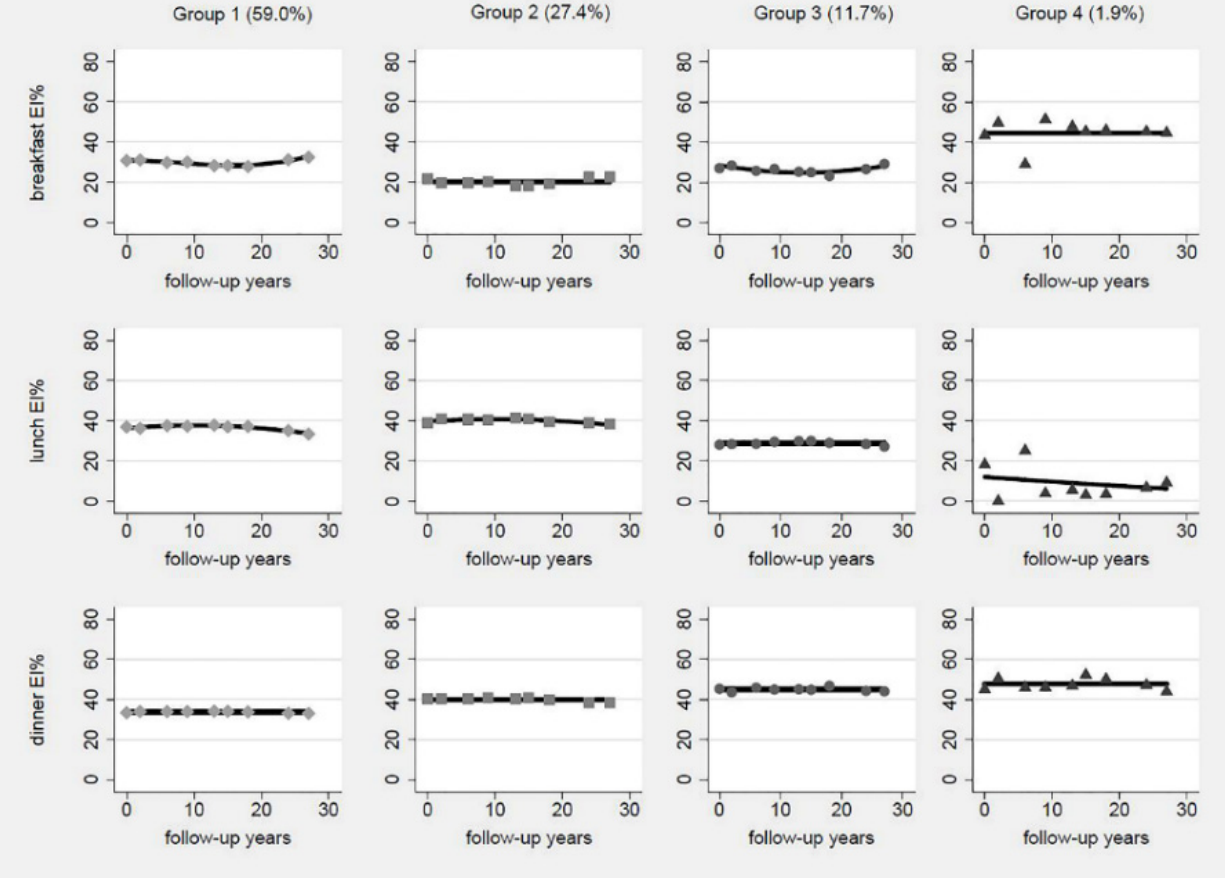
Figure 1. Estimated trajectory groups of energy intake distribution among Chinese adults. EI%, proportion of energy intake.